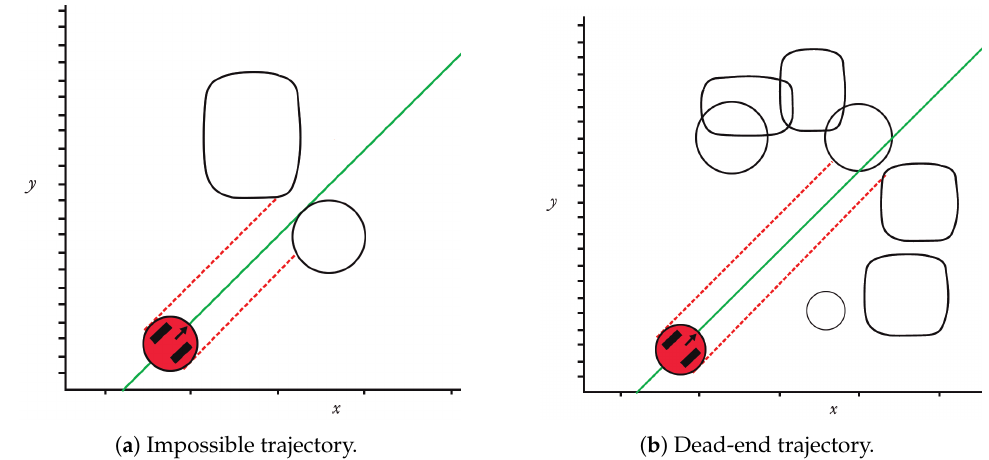
Figure 7. Initial problem representation.